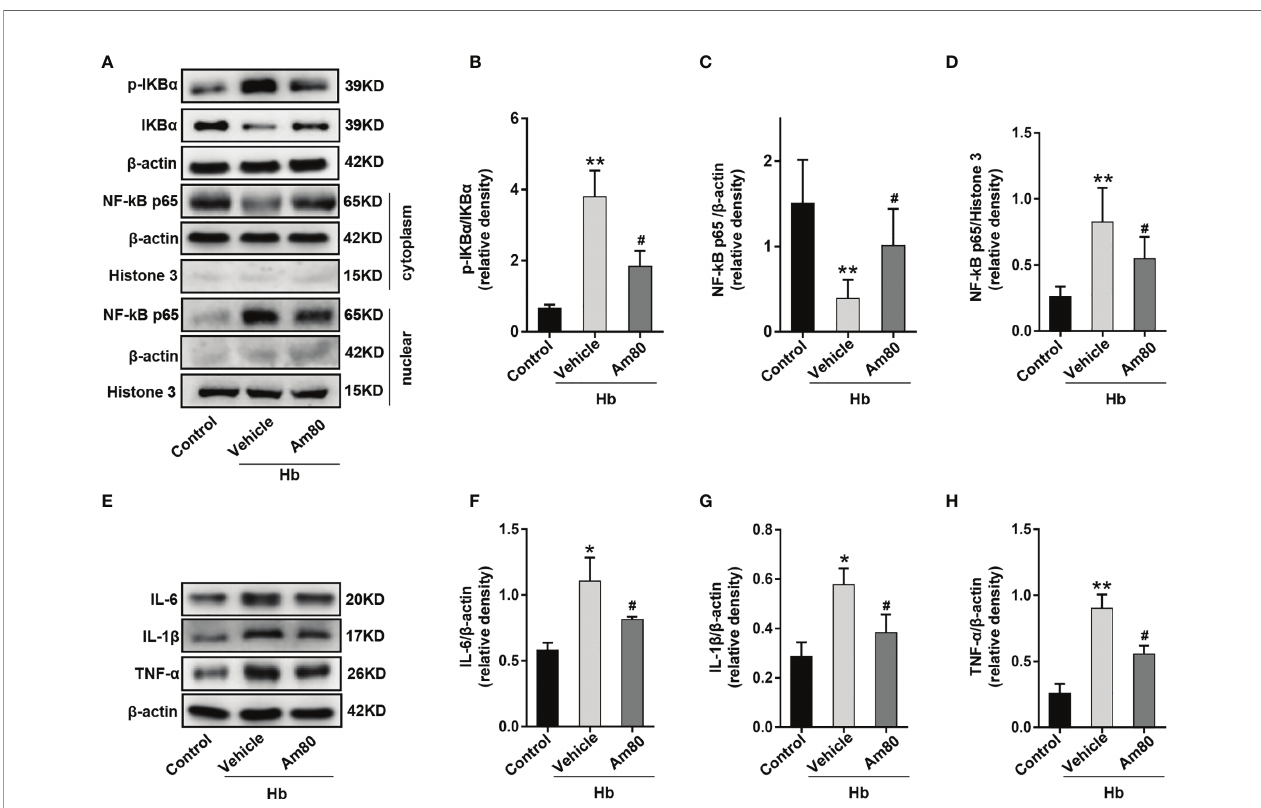
FIGURE 9 | Am80 administration suppressed the nuclear transcription of NF- k B p65 in vitro model of SAH. (A – D) Western blotting and quantitative analyses of the expression of p-IKB- a and NF-kB p65 in microglia after co-cultivation. (E – H) Western blotting and quantitative analysis of the expression of IL-6 , IL-1 b and TNF- a in microglia after co-cultivation. n = 3 per group. * P < 0.05 vs control group; ** P < 0.01 vs control group; # P < 0.05 vs Hb+vehicle